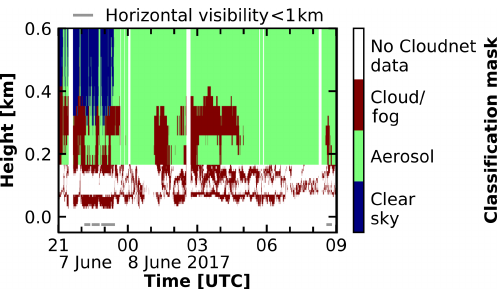
Figure 17. Low-level cloud mask for 7 June 2017 21:00UTC– 8 June 2017 09:00UTC derived from combining Polly XT and Cloudnet data. Below 165m height, red colors indicate when low- level stratus was detected using the signal-to-noise ratio (SNR) of the Polly XT 532nm near-field channel. Above 165m height, a sim- plified version of the Cloudnet target classification mask is shown. Everything which was detected as cloud (ice, liquid, or mixed- phase) is masked in red. Blue depicts clear sky, and green depicts aerosols. The grey line at the bottom indicates periods when fog was detected by means of the visibility sensor aboard Polarstern